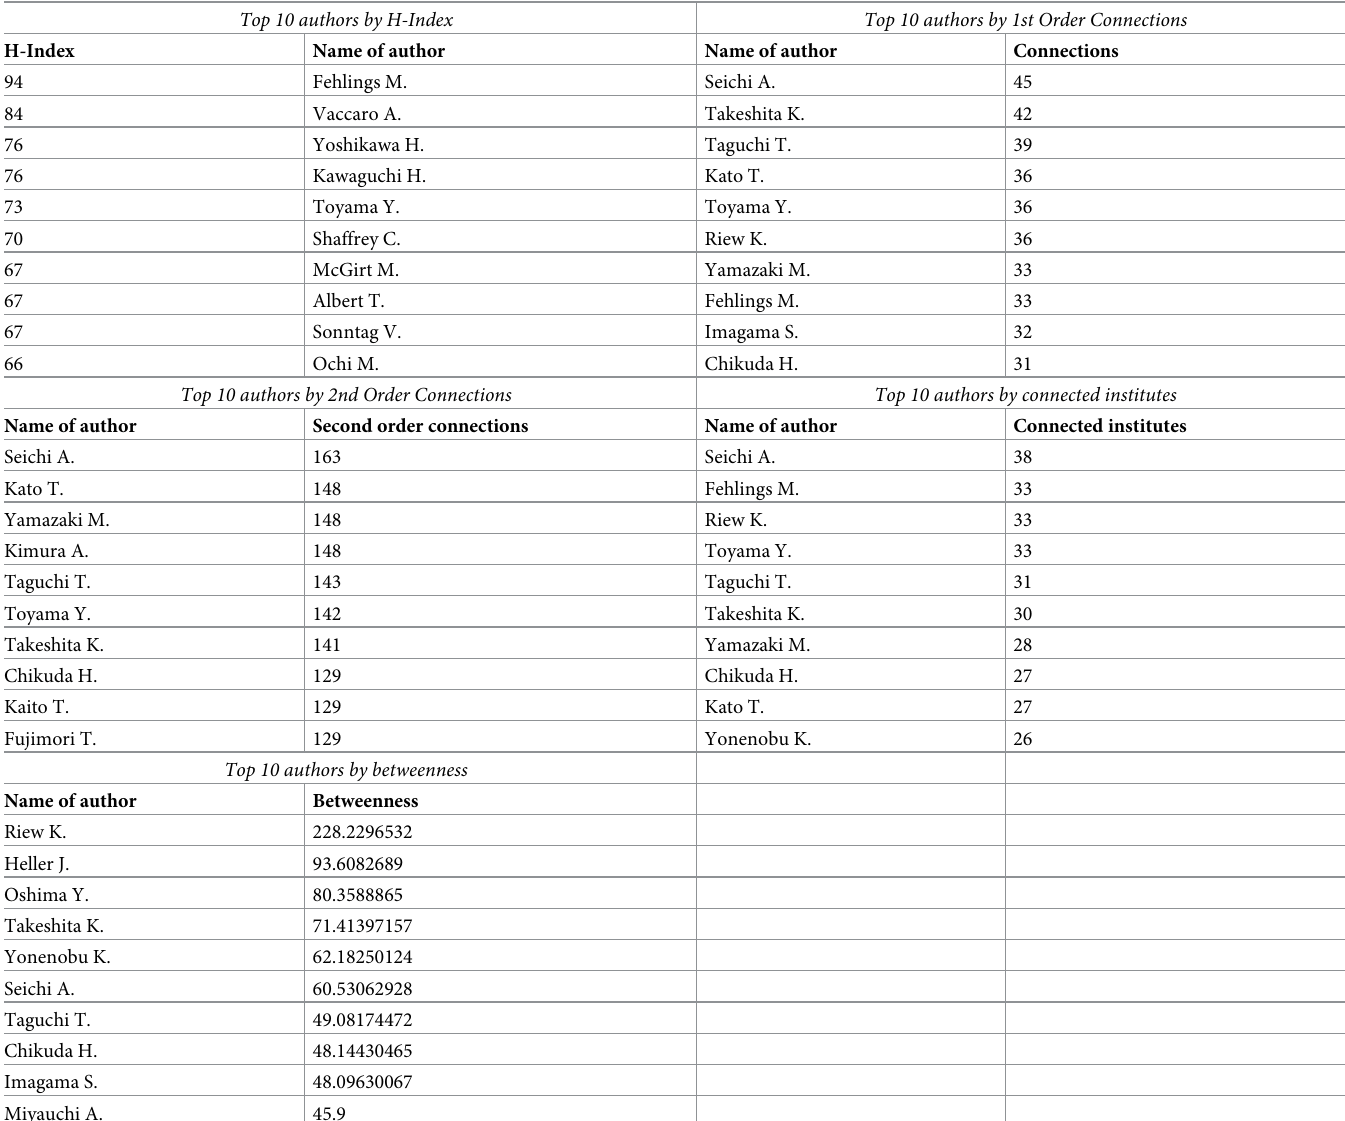
Table 1. Top 10 authors, by various network